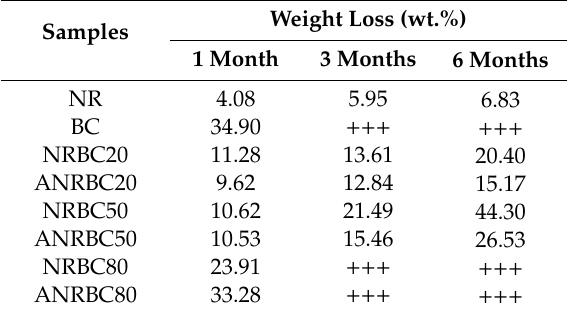
Figure 9. Water vapor transmission rates (WVTR) of NR, BC, NRBC, and ANRBC films. Table 3. Weight loss of NR, BC, NRBC, and ANRBC films in soil.